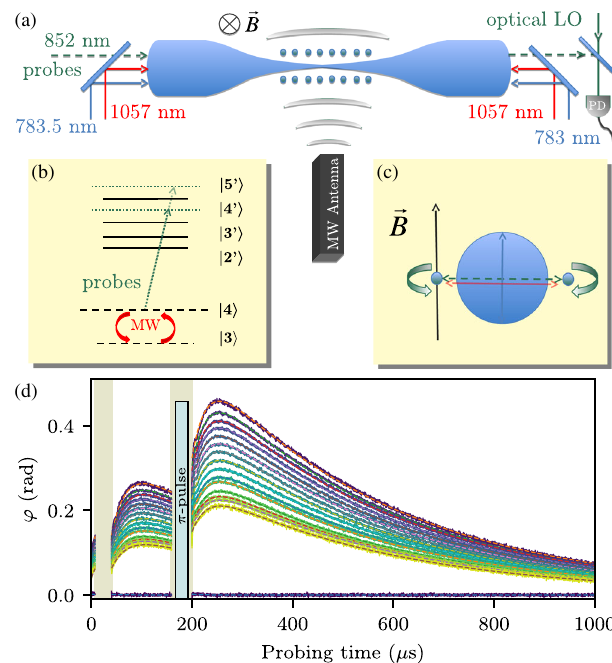
FIG. 1. (a) Sketch of nanofiber trap setup with light fields for trapping and probing and microwave source for coherent transfer between clock levels (MW: Microwave; PD: Photo detector). (b) Relevant atomic energy levels for cesium. (c) Transverse section of nanofiber with atomic trap sites, local probe light polarization, and magnetic bias field direction indicated. (d) Dis- persive detection of the clock state populations for an increasing number (bottom to top) of atoms prepared in the superposition state j Ψ i . Solid lines are averages over typically 300 realizations. Dashed lines are fits to the model presented in Eq. (2). See main text for state preparation and measurement procedure; shaded areas indicate interruption of the